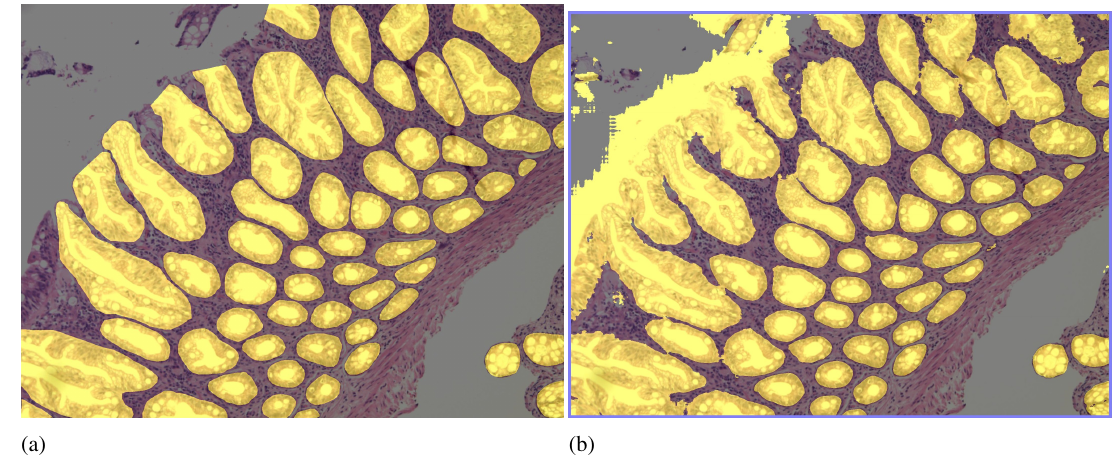
Figure 8. Results of the proposed CNN for PATH-DT-MSU dataset if trained with both normal and ”open” gland annotations; (a) is ground truth segmentation, (b) is the predicted result.